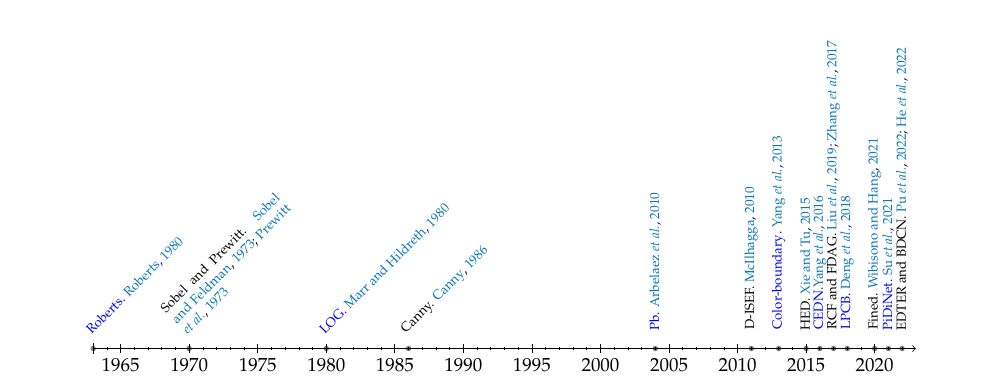
Figure 2. Chronology of detection methods without using aggregation functions or fuzzy methods